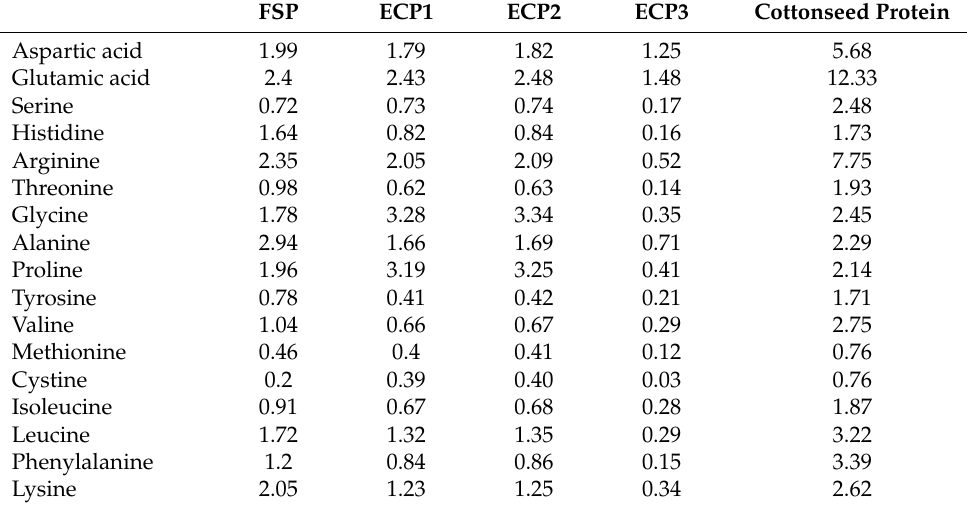
Table 2. Amino acid composition